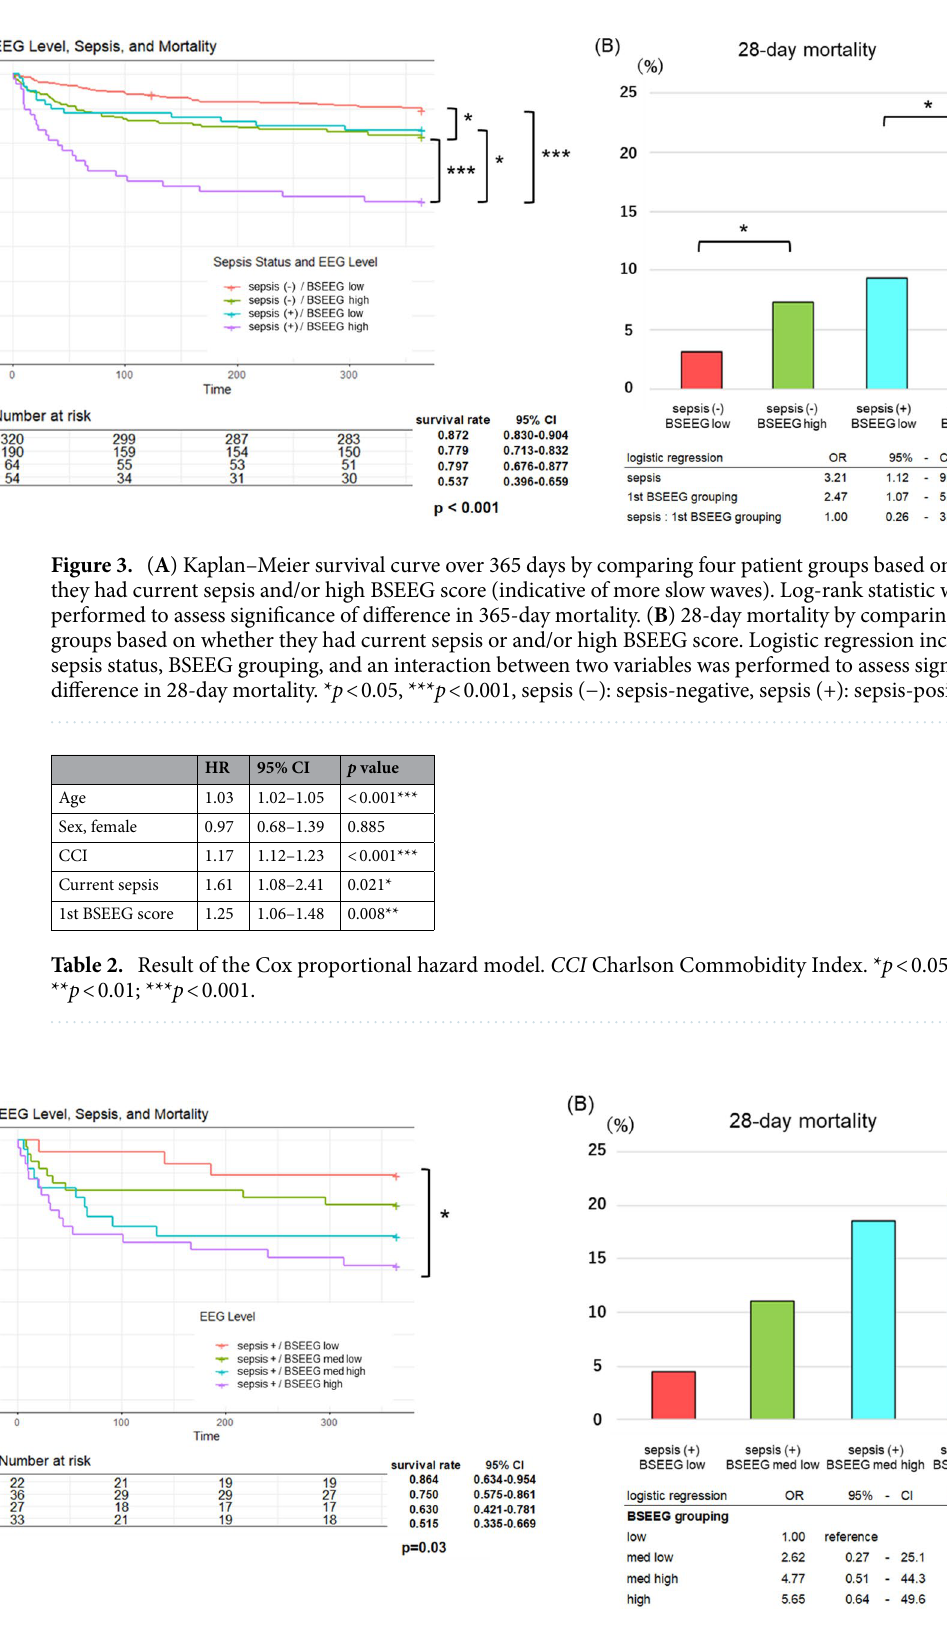
Figure 4. ( A ) Kaplan–Meier survival curve over 365 days by comparing four sepsis-positive patient groups based on BSEEG score. Log-rank statistic was performed to assess significance of difference in 365-day mortality. ( B ) 28-day mortality by comparing four sepsis-positive patient groups based on BSEEG score. Logistic regression including the BSEED score-based grouping to assess significance of difference in 28-day mortality. * p < 0.05, sepsis (+):